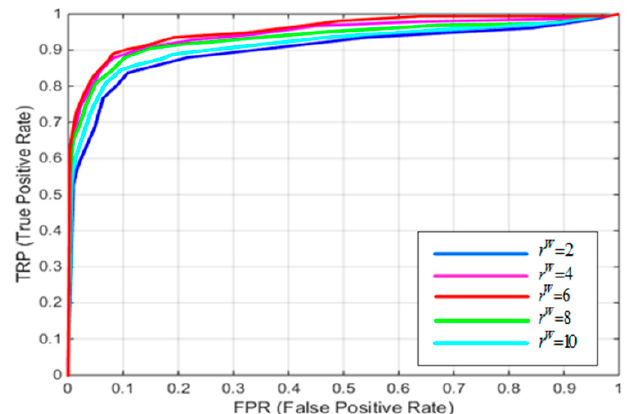
w r initial values.